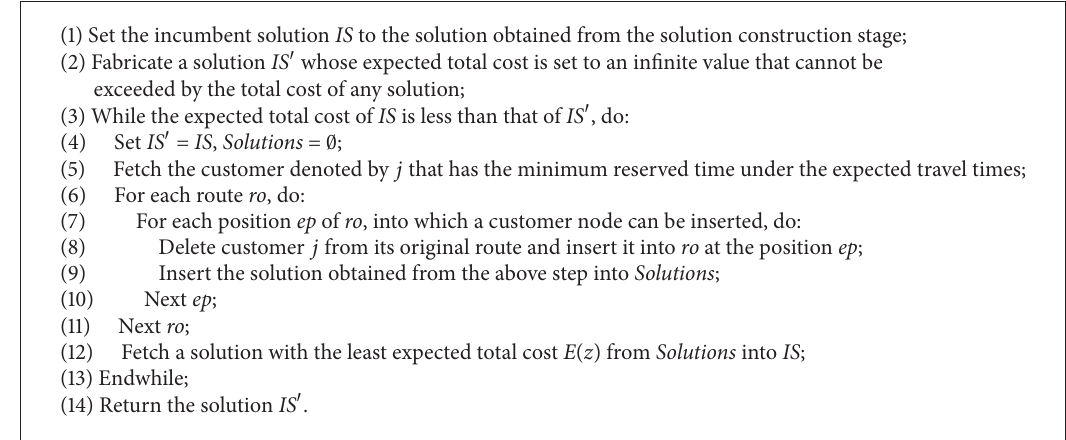
Algorithm 4: The procedure of improving a solution generated by the solution construction stage.